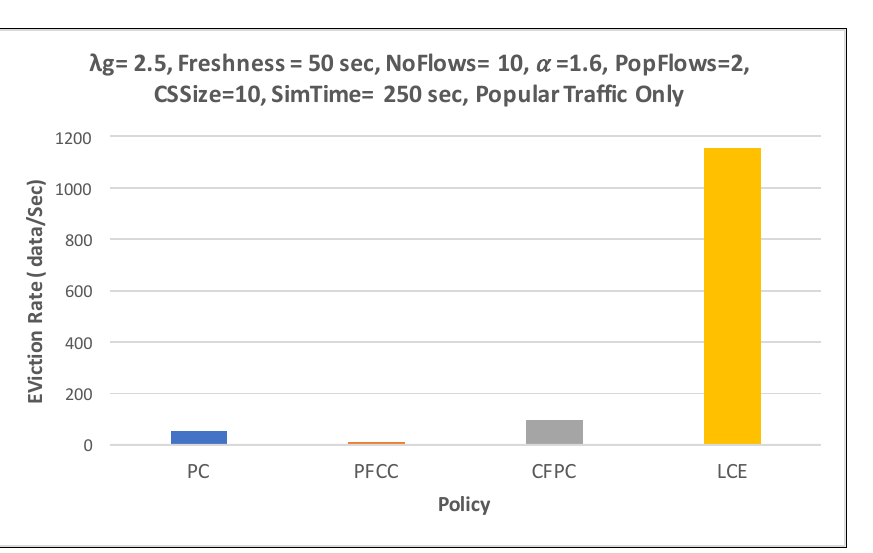
Figure 15. Eviction rate of content from popular